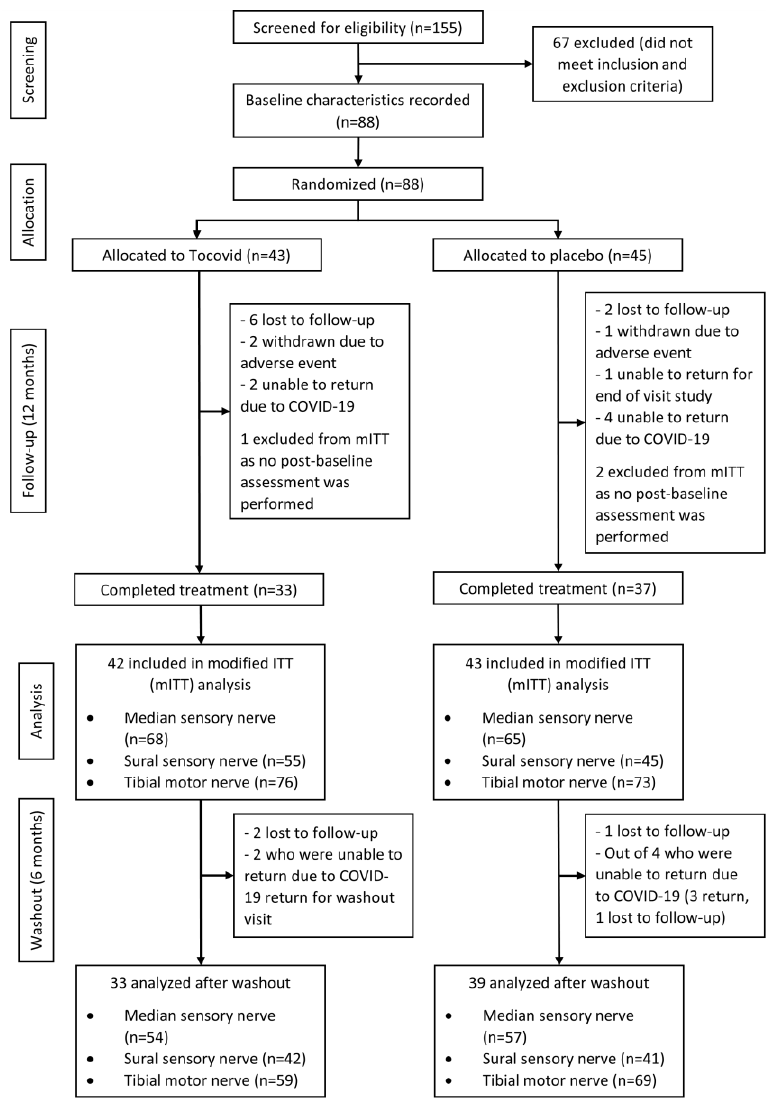
Figure 1. Summary of patient recruitment and study flow diagram.